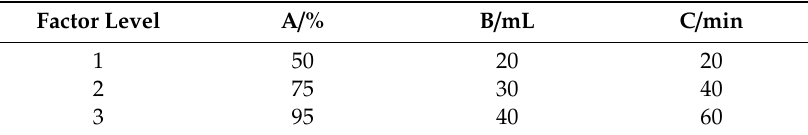
Table 9. Factors evaluated to optimize ultrasonic extraction